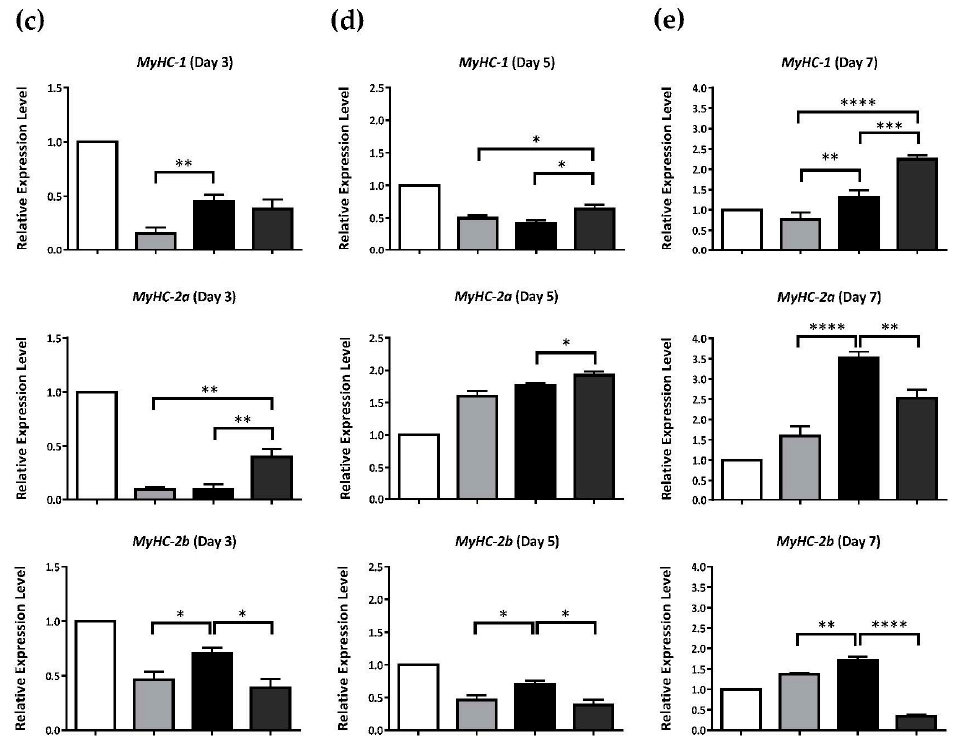
Figure 4. Effects of micropatterned GlcNAc6-SAMs on myosin heavy chain (MyHC) expression in differentiated C2C12 cells at different culture time points in a differentiation serum-free medium. ( a ) Representative quantitative real-time PCR products of MyHC s. The mRNA levels were normalized to β -actin . Lane 1: tissue culture polystyrene (TCPS); Lane 2: GlcNAc6-SAM pattern (200 µm); Lane 3: GlcNAc6-SAM pattern (500 µm); Lane 4: GlcNAc6-SAM pattern (1000 µm); ( b ) Immunocytochemical staining of MyHCs on narrow patterns and control TCPS substrate in the absence and presence of differentiation serum media, respectively. Myoblast fusion and myotube formation were found on GlcNAc6-SAM patterns after Day 5 and 7 of culture, respectively. A close-up image of multinucleated myotubes is shown in the inset panel. At Day 7, myotubes formed on the GlcNAc6-SAM patterns under differentiation serum-free conditions demonstrated long and thin morphology when compared to those on the TCPS substrate under differentiation serum-containing conditions, which promoted the formation of thicker myotubes with numerous branched structures. Shown are confocal images of differentiated cells stained with anti-MyHC antibody to monitor myotube formation (red). DAPI was used to visualize nuclei (blue). Scale bars represent 200 µm; ( c – e ) Individual MyHC mRNA expression profiles on various geometries. Values are the mean ± SEM, n = 9 per each sample. * p < 0.05, ** p < 0.01, *** p < 0.001 and **** p < 0.0001.